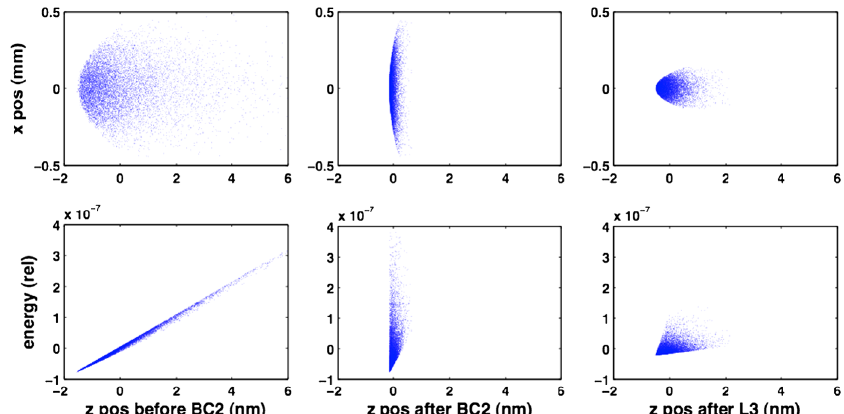
FIG. 7. To demonstrate the emittance cancellation effect, we track a longitudinal delta slice (zero length) following the laser modulation. Emittance effects increase the slice length before the second chicane, BC2 (top left, x vs z ), but the off-crest accelerating section introduces a chirp to the beam (bottom left, energy vs z ). The second chicane then recompresses the bunch by the compression factor, j (cid:1) j (center). Following the final accelerator section, L3, the slice starts to spread out again (right). The bunch head is to the